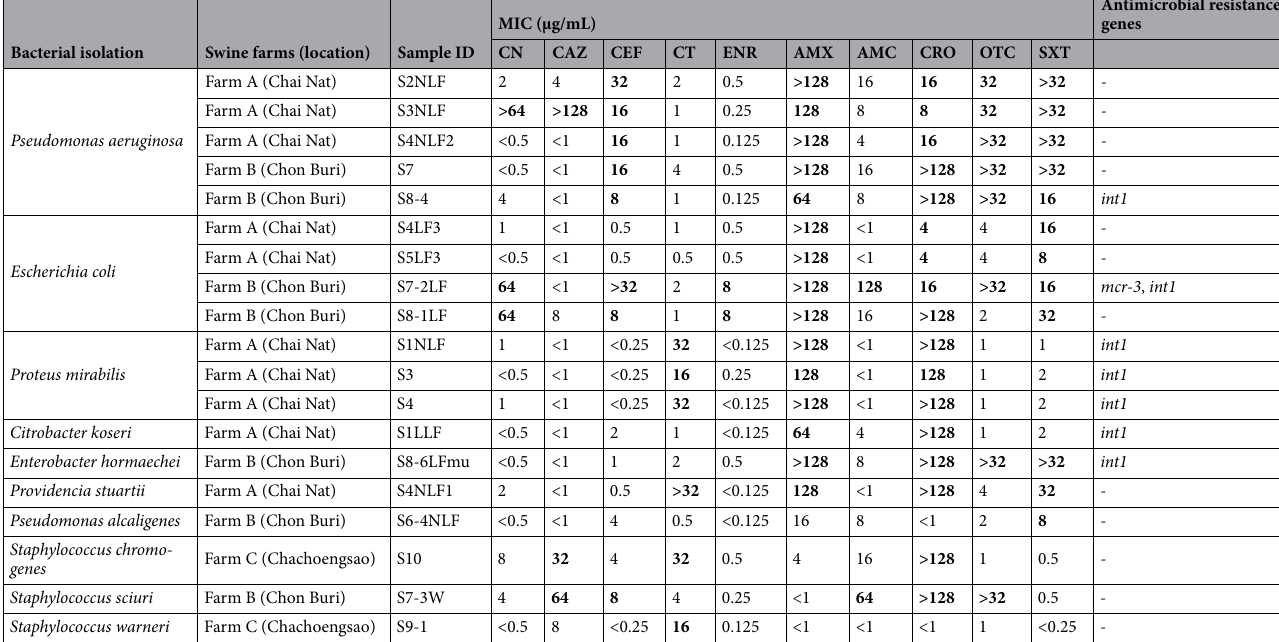
Table 1. Bacterial identification, antimicrobial susceptibility against 10 antimicrobial agents, and antimicrobial resistant genes detection of pathogens isolated from fresh boar semen CN Gentamicin, CAZ Ceftazidime, CEF Ceftiofur, CT Colistin, ENR Enrofloxacin, AMX Amoxicillin, AMC Amoxicillin trihydrate: Potassium clavulanate (4:1), CRO Ceftriaxone, OTC Oxytetracycline, SXT Trimethoprim: sulfamethoxazole (1:19) Bold indicate the resistant zone Chai Nat province is in central region of Thailand. Chonburi and Chachoengsao provinces are in eastern region of